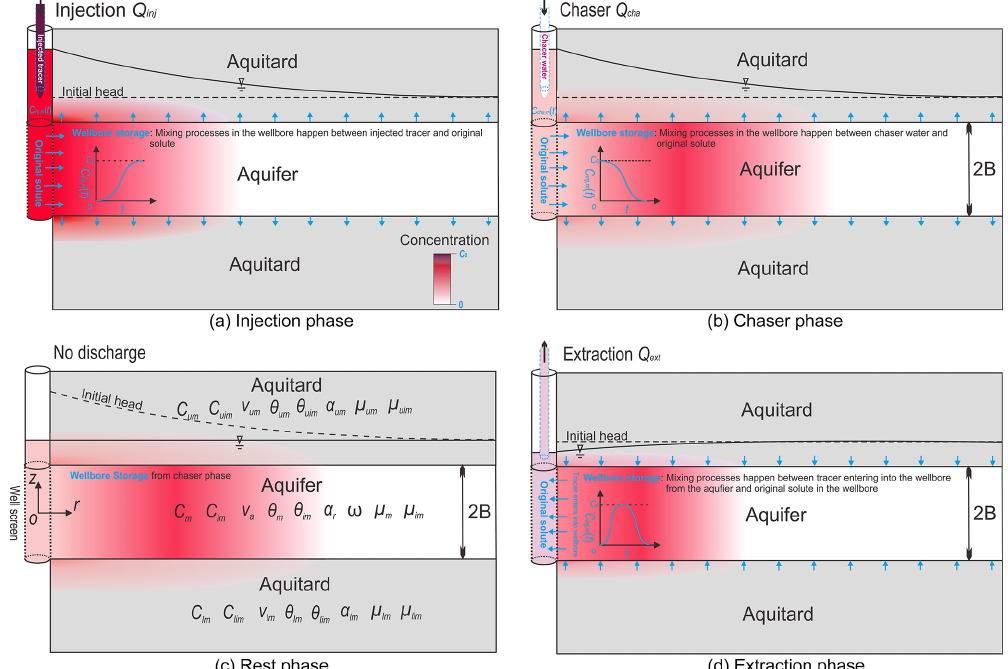
Figure 1. The schematic diagram of the SWPP